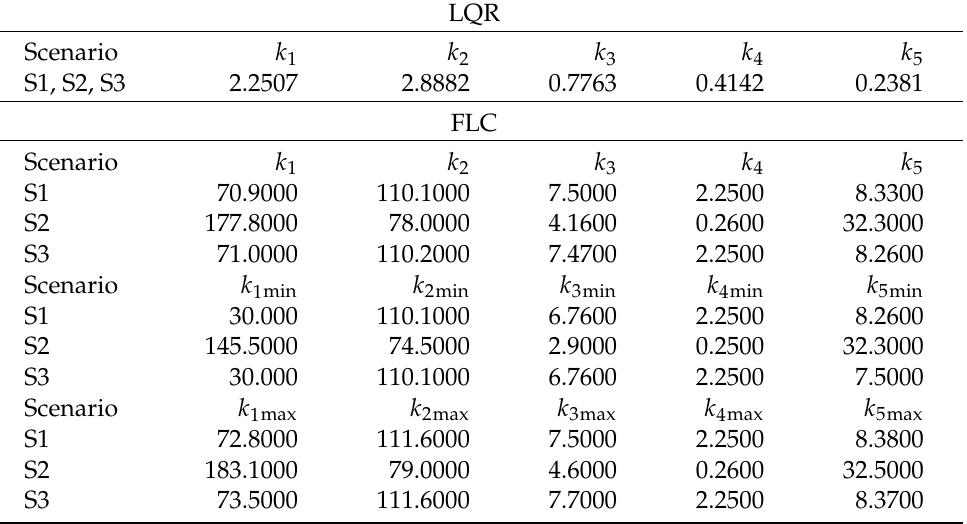
Table 5. Controller gains, Area